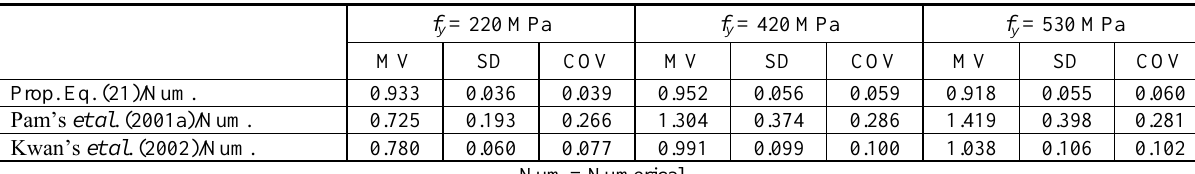
Table 1. Verification of curvature ductility predictions f y = 220 MPa f y = 420 MPa f y = 530 MPa MV SD COV MV SD COV MV SD COV Prop. Eq. (21)/Num. 0.933 0.036 0.039 0.952 0.056 0.059 0.918 0.055 0.060 Pam’s et al . (2001a)/Num. 0.725 0.193 0.266 0.281 Kwan’s et al . (2002)/Num. 0.780 0.060 0.077 0.991 0.099 0.100 1.038 0.106 0.102 Num.=